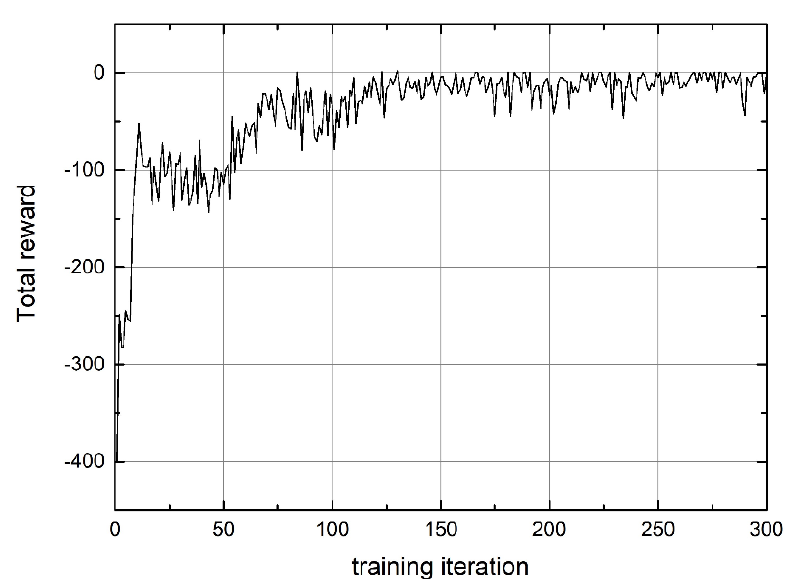
Figure 11. Average reward for multi-ship collision avoidance.